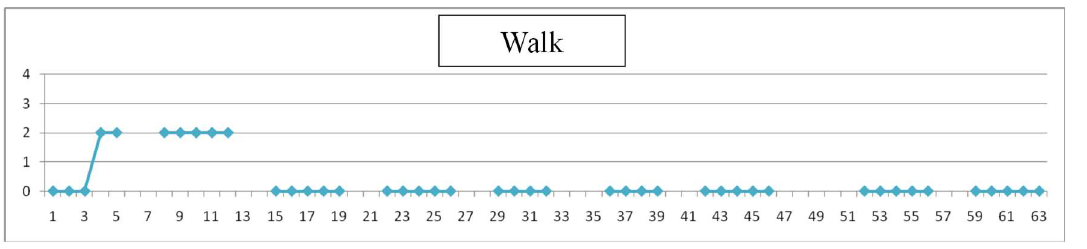
Figure 11. “Walking” reached soon a level of “no difficulty” with training.